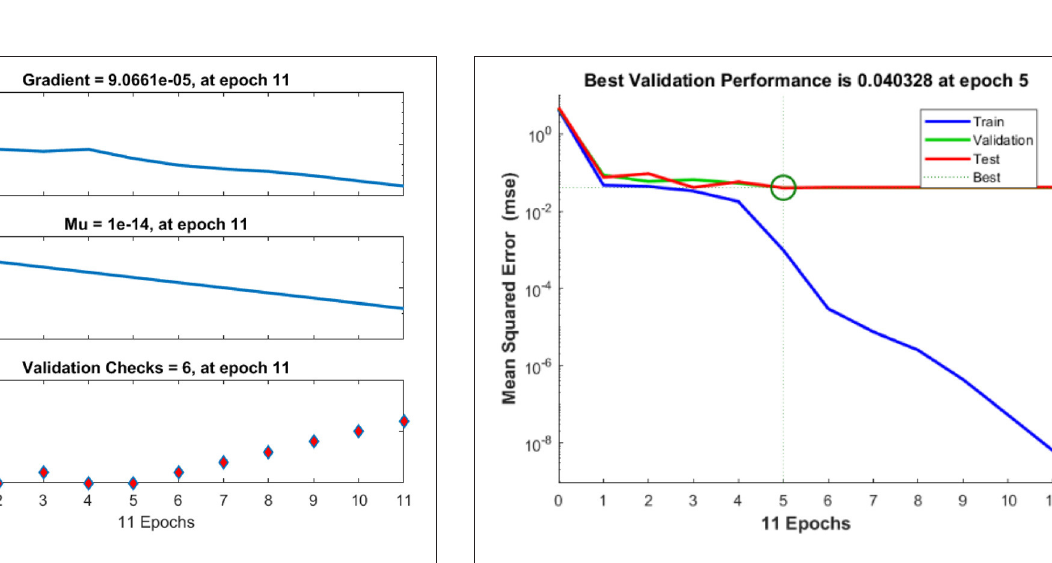
FIGURE 15 | Performance analysis of neural network based on the ID function model of the